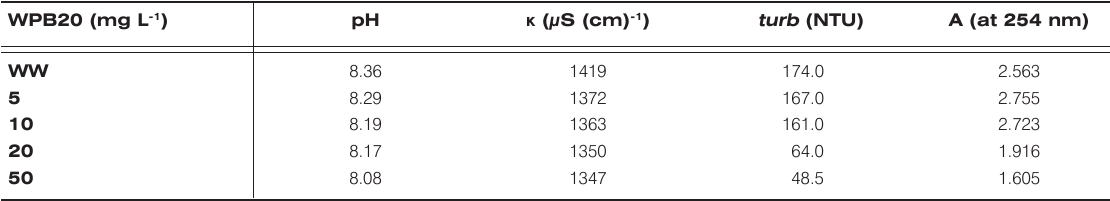
Table 3. Measurements when using flocculant WPB20.